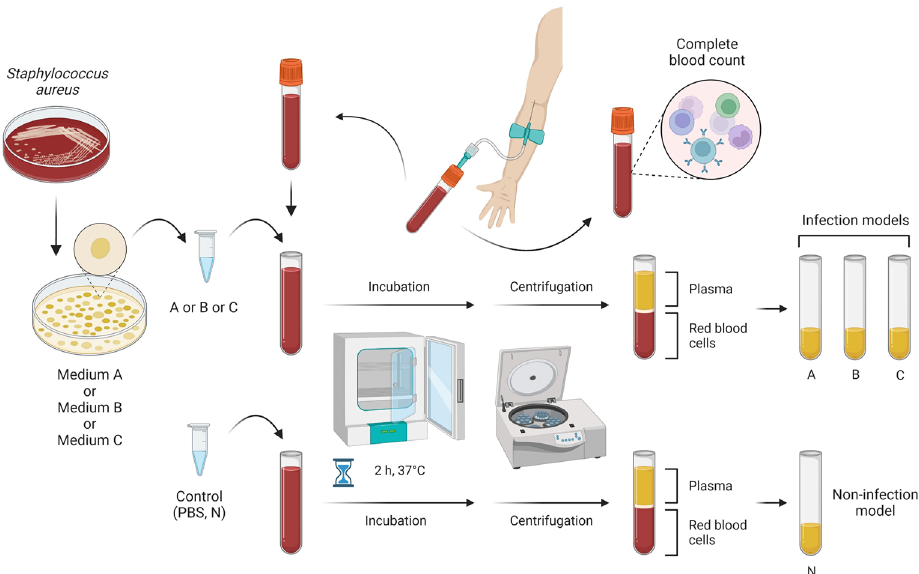
Figure 1. Schematic diagram of the experiment. Created with